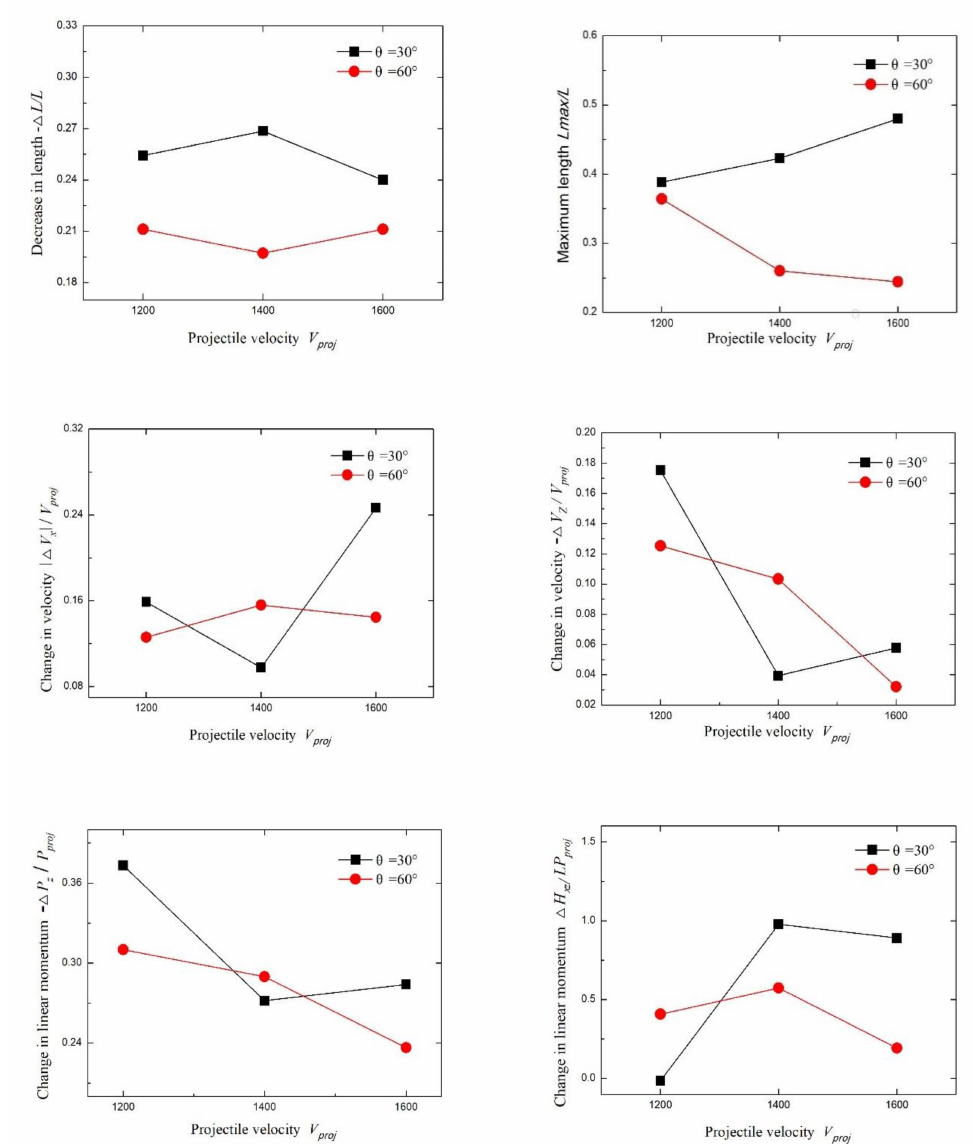
Figure 15. Influence of the projectile velocity V proj at di ff erent inclination